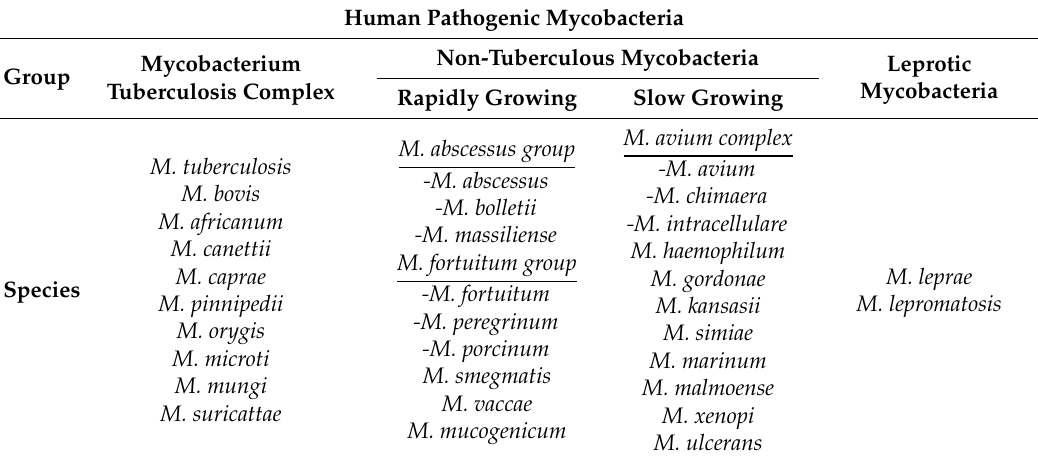
Table 1. Human pathogenic